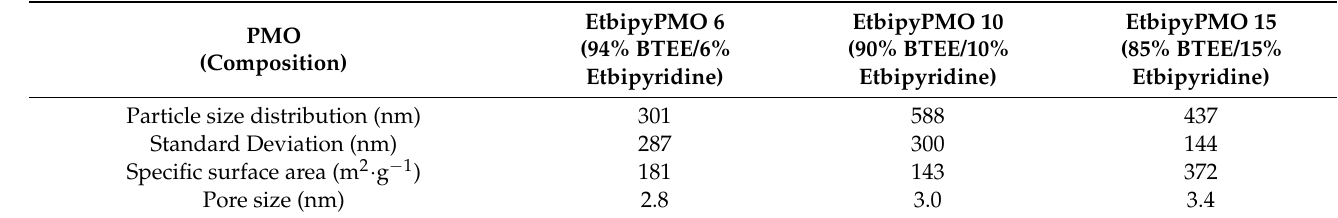
Figure 15. ( a ) TEM image of EtbiPyPMO 15 scale bar 500 nm. ( b ) Nitrogen adsorption–desorption at 77 K. Insert BJH desorption (dV/dlog(w)) Pore Volume. Table 5. Size distribution and standard deviation values of the BTEE/Etbipyridine PMO NPs analyzed from N 2 sorption experiments.